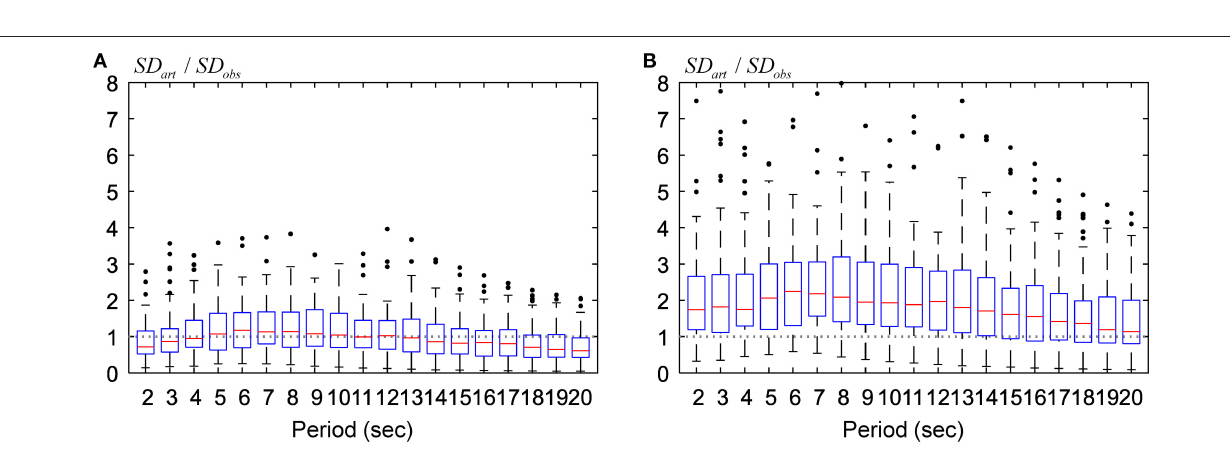
that the fault rupture propagates concentrically from the source with the propagating speed V r 2900(m/s). The limit of the = uncertainty level is given by α 1.1 and β 0.95. The area = = of asperity, the seismic moment, the rise time are given by S a = 5(km 2 ), M 0 a 1.79 10 17 (Nm), τ a 0.43(sec), τ b 1.03(sec). 351 ◦ , dip 50 ◦ , rake = × = = = = Figure 12C shows the comparison between the observation 4.06 10 17 (Nm). It is assumed = ×